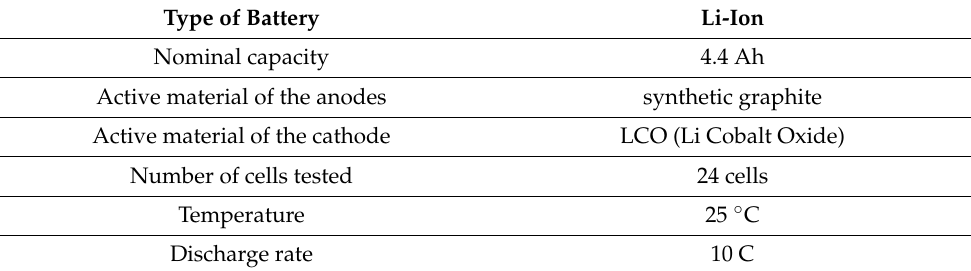
Table 2. The description of the commercial Li-ion batteries tested.